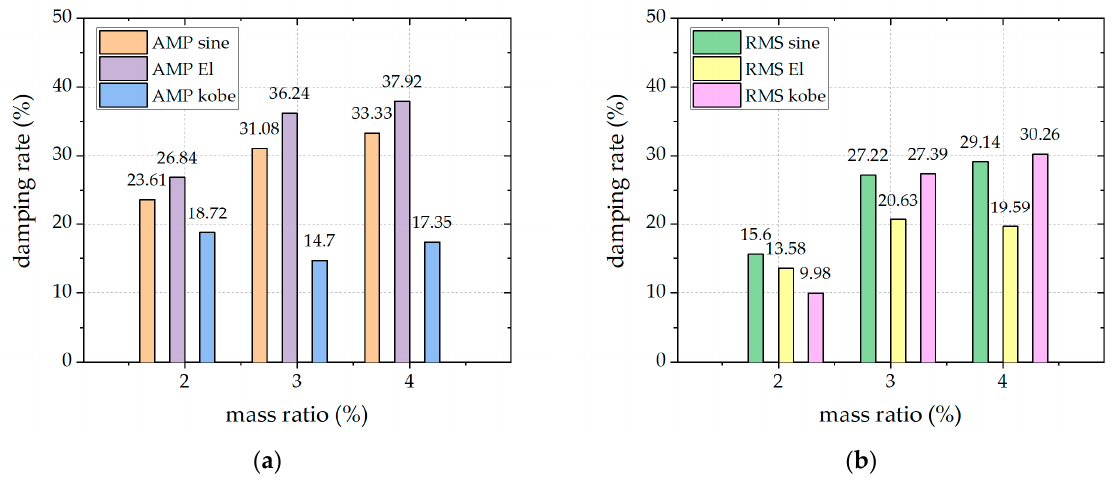
Figure 5. Influencing factor: mass ratio: ( a ) AMP (peak); ( b ) RMS (root mean square).